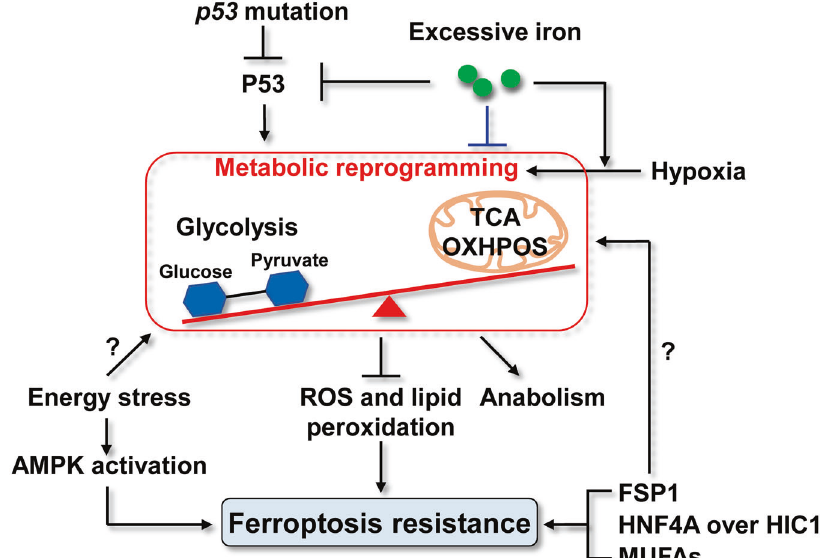
Fig. 5 The mechanisms underlying ferroptosis resistance in cancer cells. In cancer cells, direct and indirect mechanisms may be involved in inducing ferroptosis resistance. Elevated levels of FSP1 and MUFAs, and a disrupted balance between HNF4A and HIC1 can directly inhibit ferroptosis in cancer cells. Furthermore, p53 mutations can directly induce ferroptosis resistance. In contrast, metabolic reprogramming could indirectly and substantially induce ferroptosis resistance by integrating iron metabolism disorders, dysregulated p53 levels, and mitochondrial dysfunctions p53 mutations and hypoxia induce metabolic reprogramming, including enhanced glycolysis in the cytosol and inhibition of the TCA cycle and OXPHOS in the mitochondria. This reduces ATP production and ROS generation, which can attenuate lipid peroxidation and lead to ferroptosis resistance. Accumulated iron in cancer cells can induce p53 mutations and also directly promote metabolic reprogramming. Energy stress-induced AMPK activation also contributes to ferroptosis resistance in cancer